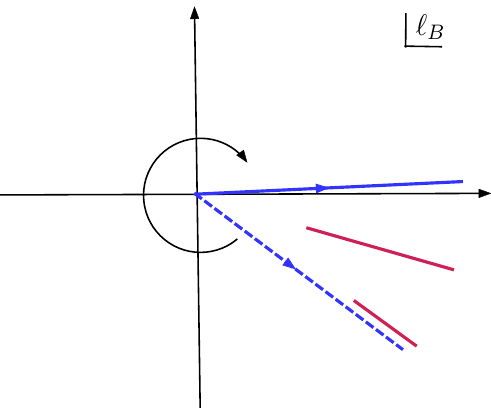
Figure 7 . Here we illustrate the argument for rotating the ‘ + contour for (cid:28) a < (cid:28) b . After the B rescaling ‘ + ‘ + e (cid:0) i(cid:28) b , the ‘ + contour lies along the dashed blue line. The branch cuts lie along B ! B B the red lines from ‘ + = ( 2 Y B :Y a ) e (cid:0) i(cid:28) a to and ‘ + = ( 2 Y B :Y b ) e (cid:0) i(cid:28) b + i(cid:15) to . The contour B B (cid:0) 1 (cid:0) 1 and can therefore be rotated back to the positive real axis without crossing the cuts. A similar argument works for (cid:28) a > (cid:28) b